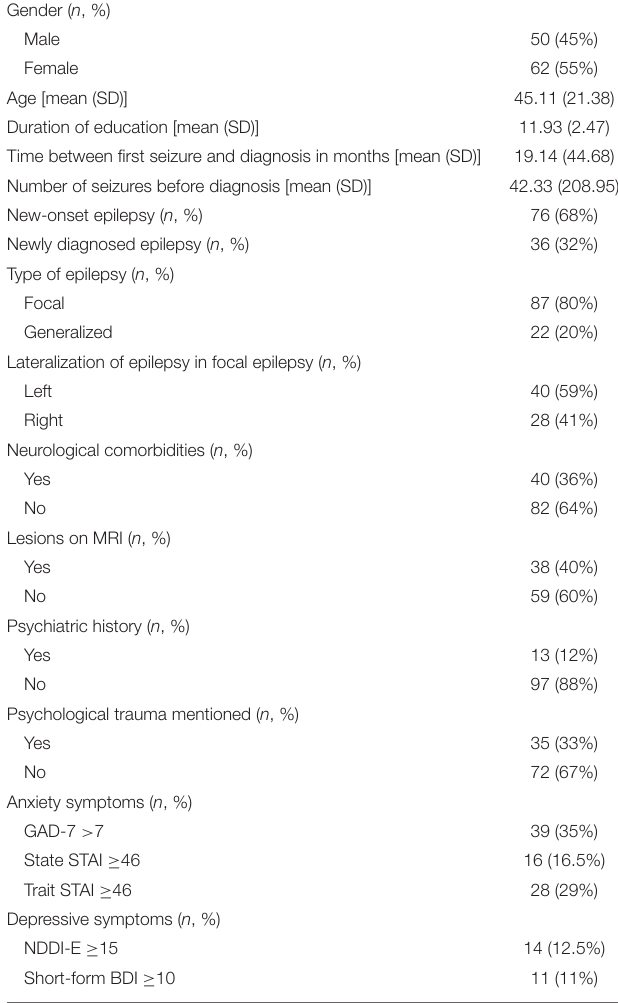
TABLE 1 | Sociodemographic and medical data ( n =